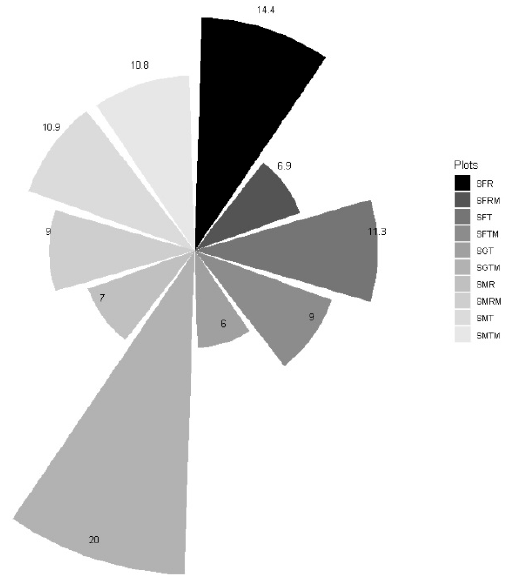
Figure 10. Undergrowth return fraction values.